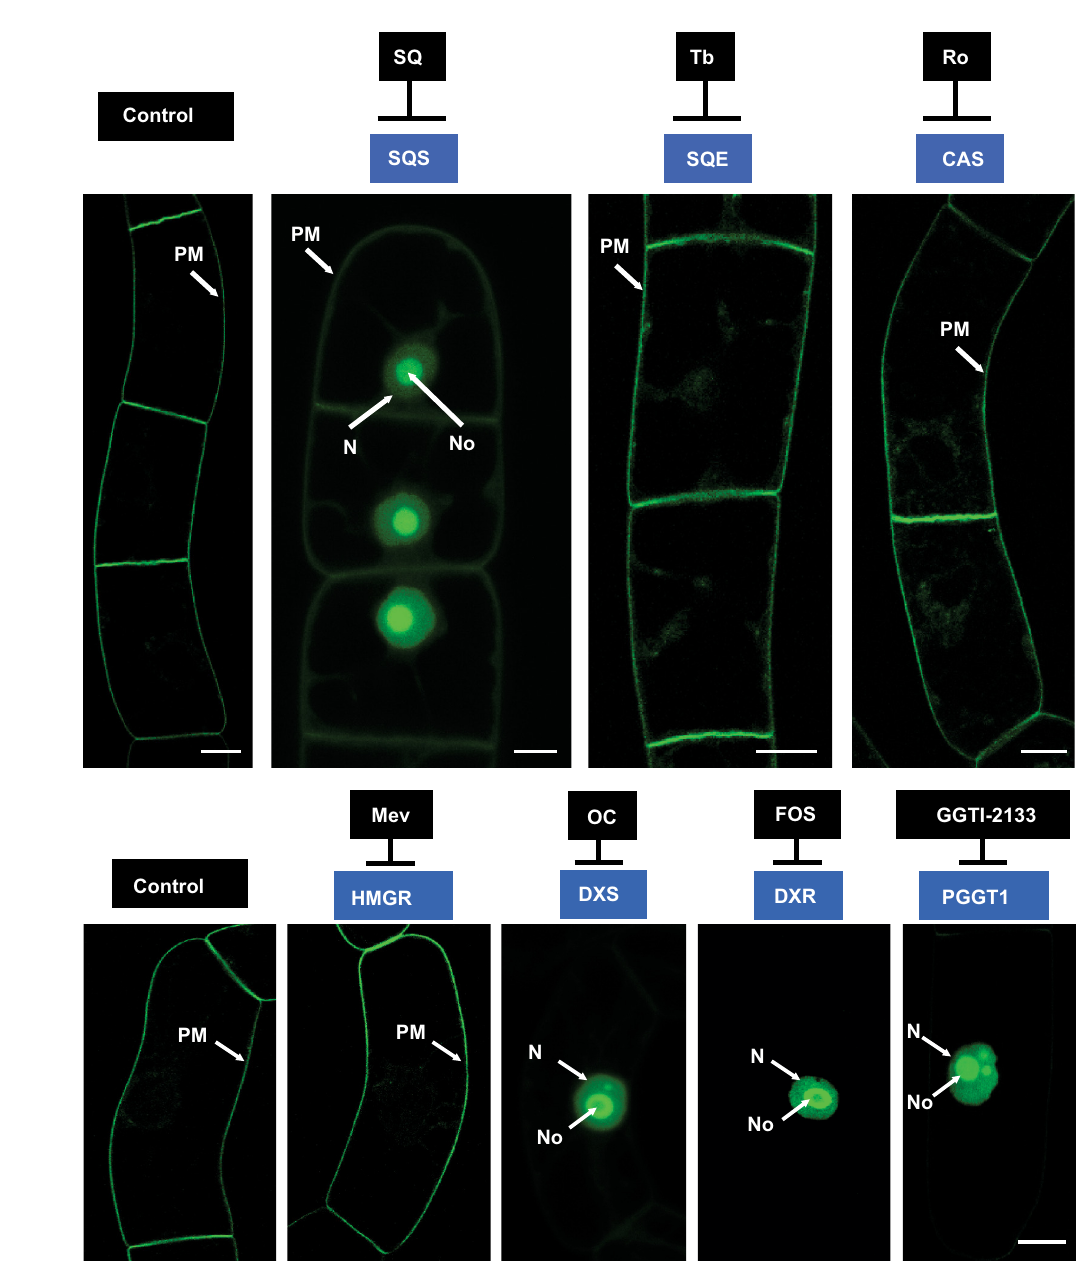
Figure 1. a) Localization of H -GFP-BD-CVIL in transgenic BY-2 cells after treatment with inhibitors of sterol biosynthesis. Control: 6 GFP fluorescence is almost exclusively associated with the plasma membrane (PM). SQ: Cells treated with squalestatin-1 (SQ), a specific inhibitor of squalene synthase (SQS) show partial translocation of GFP fluorescence to the nucleus (N) and the nucleolus (No). Tb: Cells treated with terbinafine (Tb), an inhibitor of squalene epoxidase (SQE), showing GFP fluorescence associated with the plasma membrane (very faint fluorescence is also seen in the cytoplasm). Ro: Localization of H -GFP-BD-CVIL in cells treated with Ro48-8071, a general inhibitor 6 of oxidosqualene cyclases (OSC), such as cycloartenol synthase (CAS) in plants, showing GFP fluorescence associated with the plasma -GFP-BD-CVIL fusion protein in transgenic BY-2 cells after treatment with inhibitors of key enzymes membrane. b) Localization of H 6 of the MVA and MEP pathways. Control cells were induced 15 h before observation by confocal microscopy as described. Treatment with inhibitors occurred 3 h prior to dexamethasone induction 116 . Mevinolin (Mev, 5µM) did not cause any detectable effect on the localization of GFP-BD-CVIL fusion protein when compared to the untreated control. GFP fluorescence was predominantly located at the periphery of the cells. By contrast, Fosmidomycin (Fos) as well as oxoclomazone (OC) (here both at 30µM) caused a mislocalization of the fusion protein to the nucleus and in particular to the nucleolus. The same phenotype could also be observed after application of 40µM GGTI-2133, a peptidomimetic inhibitor of protein geranylgeranyl transferase 1 (PGGT1). White bar =